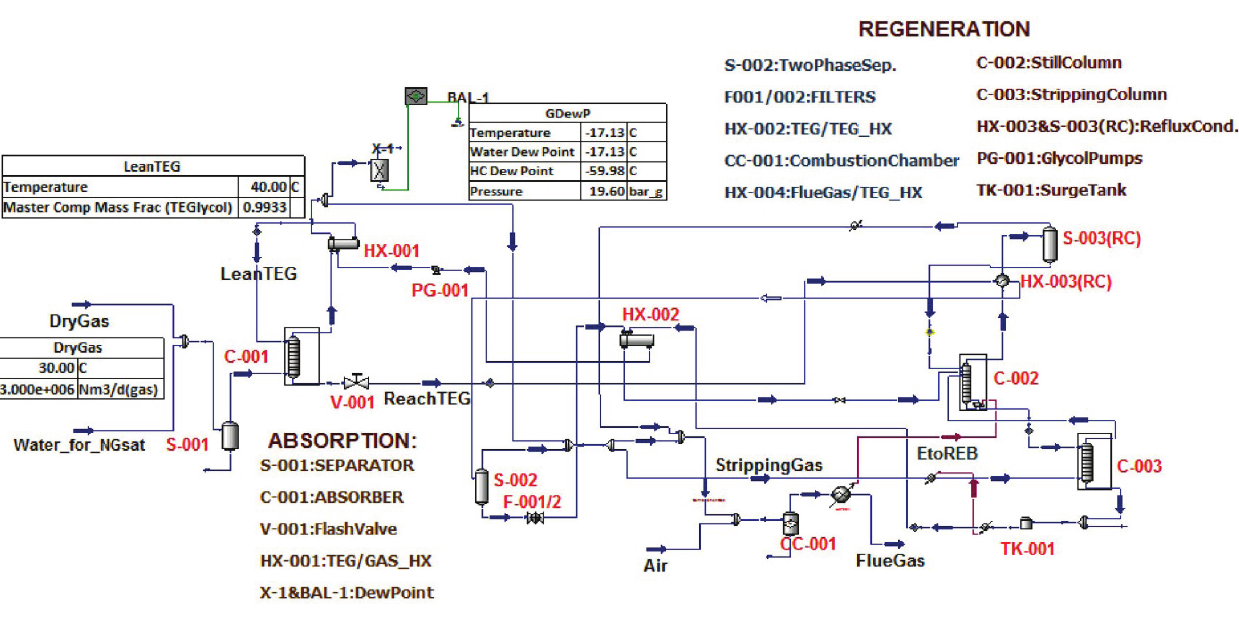
Fig. 3 – Simulation scheme of a typical natural gas TEG dehydration